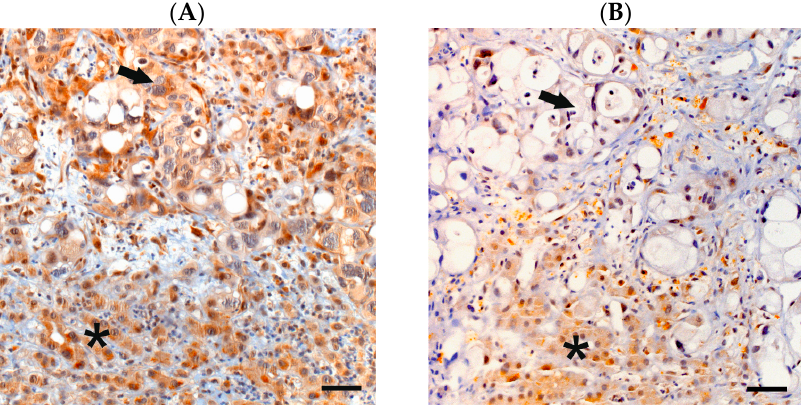
Figure 1. Lost and preserved mothers against decapentaplegic homolog 4 (SMAD4) expression in pancreatic cancer (PC) tissue. Immunohistochemical staining of SMAD4 in exemplary PC samples shows preserved ( A ) as well as lost SMAD4 expression ( B ) in the tumor tissue (arrow) whereas SMAD4 expression is preserved in adjacent liver parenchyma (asterisk). 200× magnification; scale bars indicate 50 µm.